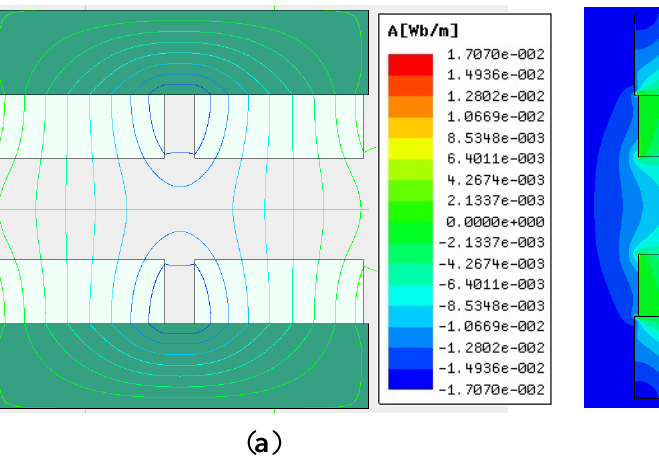
Figure 13. FEA results. ( a ) flux contour profile. ( b ) distribution of magnetic flux